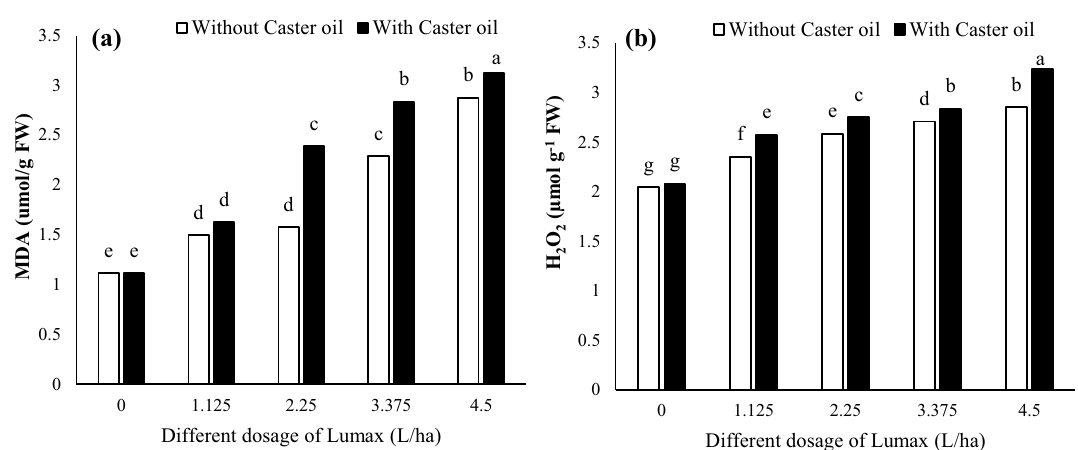
Figure 3. Changes in ( a ) MAD and ( b ) H 2 O 2 of Solanum nigrum in response to different doses of Mesotrion + S-metolacholor + Terbuthylazine with and without Castor oil. Each value is the mean of four replicates. Different letters represent significant differences ( P <